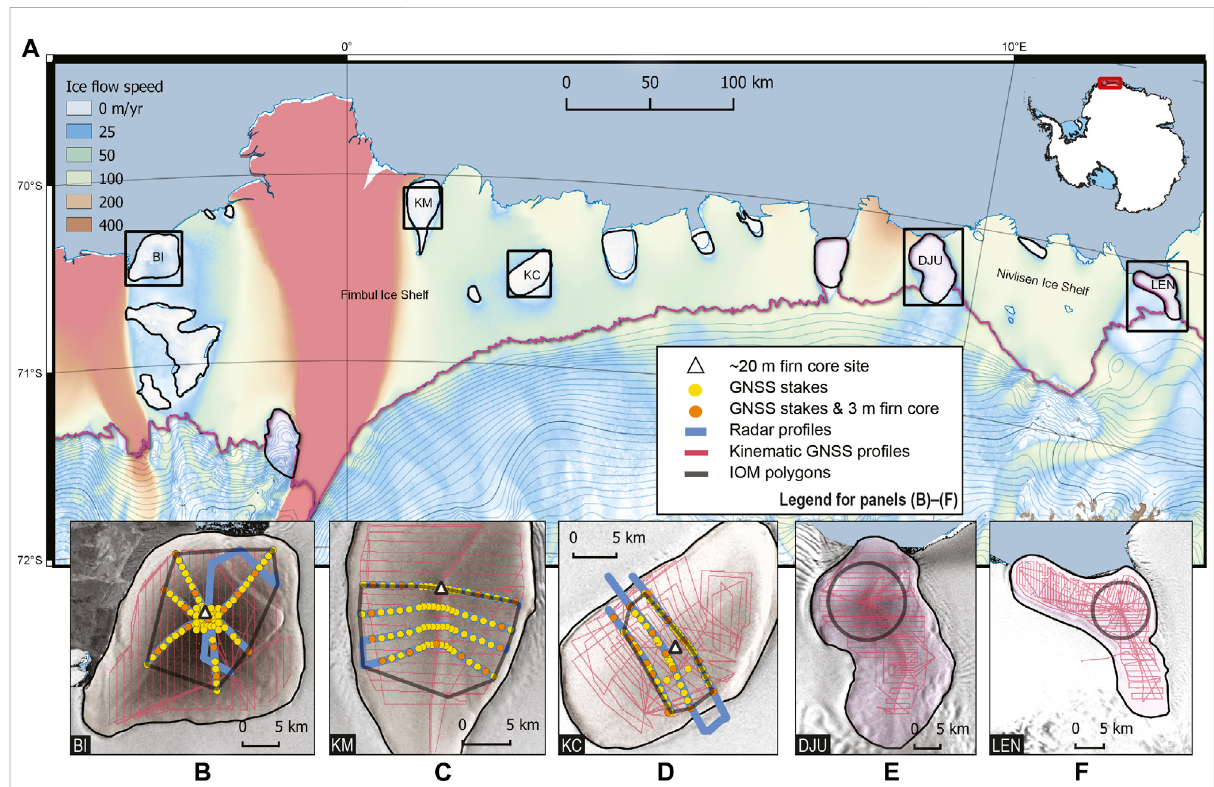
FIGURE 1 Ice rises in central Dronning Maud Land. Panel (A) shows ice rises outlined in black (Matsuoka et al., 2015) over a fl ow speed map (Rignot et al., 2011). The grounding zone of the ice sheet is illustrated in thick pink (Bindschadler et al., 2011). Inset shows the coverage of this map. Black boxes show the extent of sub-panels (B – F) of ice rises investigated in this study. Acronyms stand for BI: Blåskimen Island, KM: Kupol Moskovskij, KC: Kupol Ciolkovskogo,DJU:Djupranen,andLEN:Leningradkollen.Panels (B – F) showclose-upviewsoficerisesandthevarious fi elddatacollectedand discussed in this study. The background of these panels is Radarsat-1 satellite imagery (Jezek et al., 2002). Maps are projected to the Antarctic Polar Stereographic view (EPSG: 3031) using Quantarctica (Matsuoka et al.,